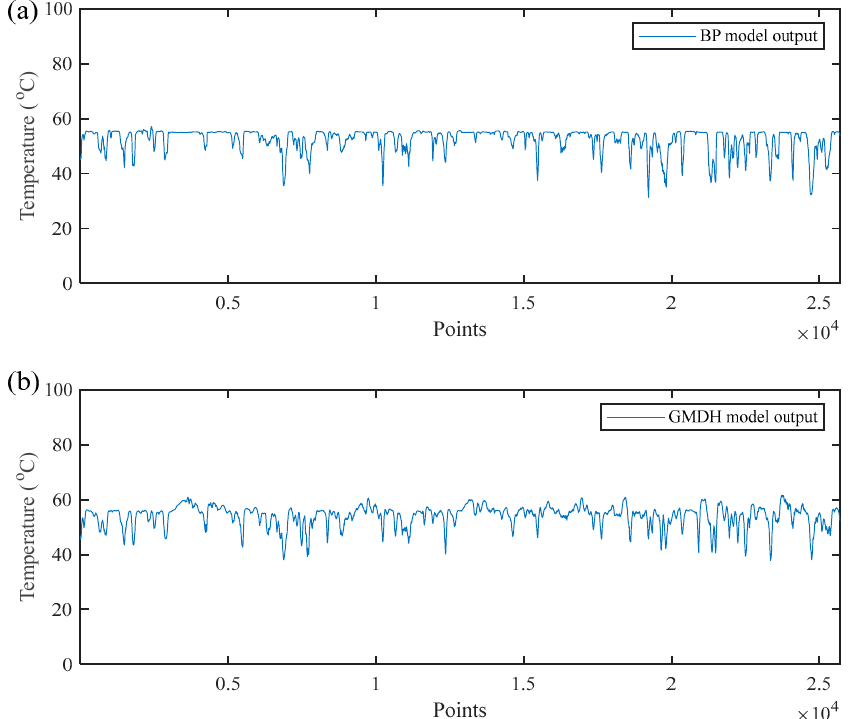
Figure 10. Predicted temperature of the gearbox oil gained from both models. ( a ) BP model output, ( b ) GMDH model output.